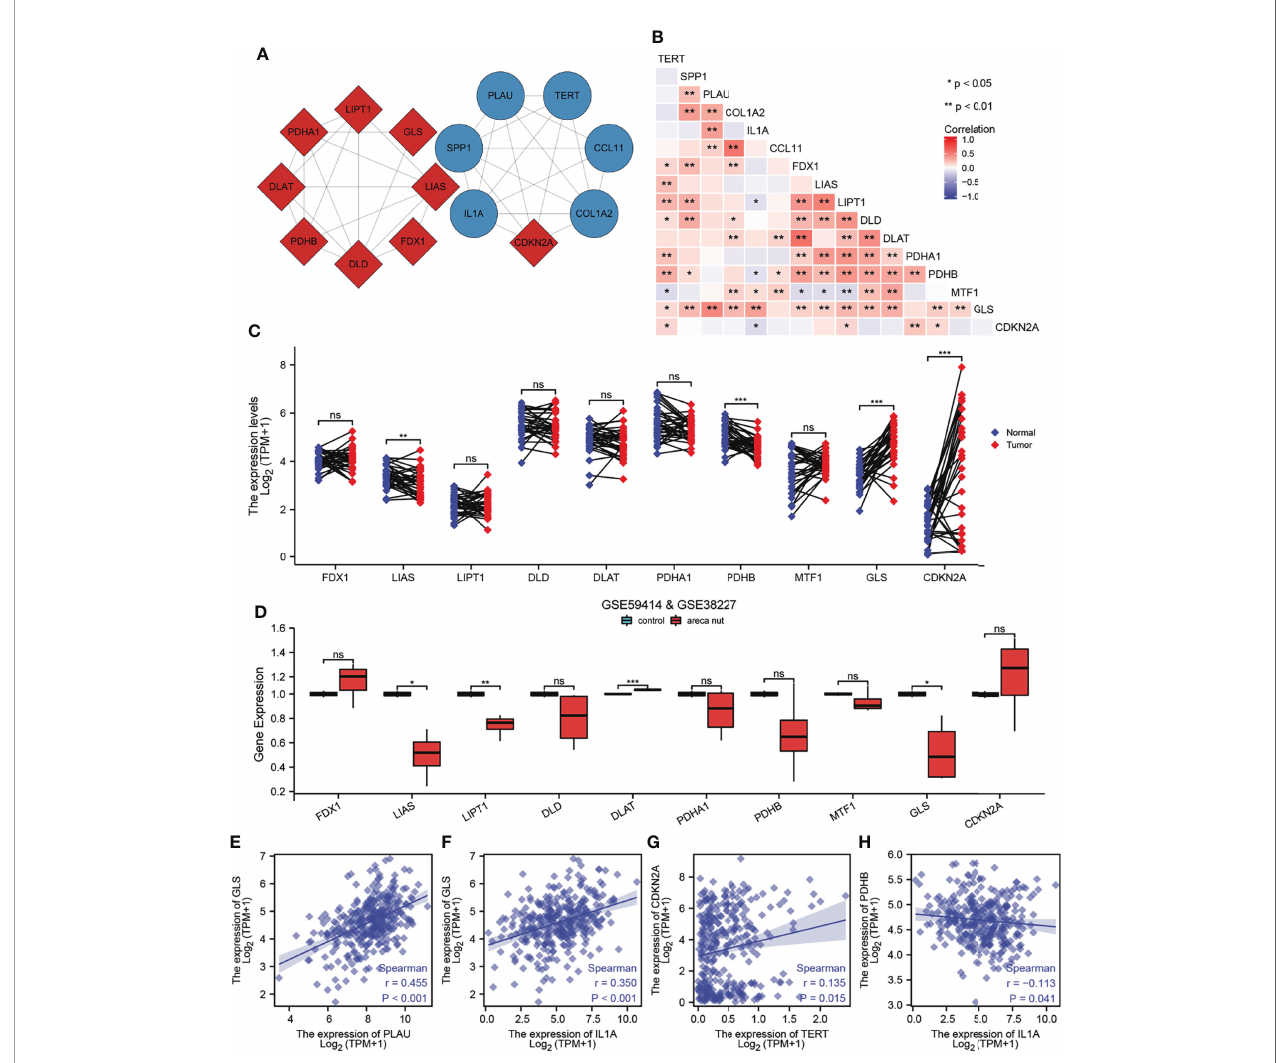
FIGURE 6 | Correlation analysis between AFOC-DEGs and cuproptosis-related genes. (A) PPI network shows bonding between AFOC-DEGs and cuproptosis- related genes. (B) Heatmap shows the correlation between AFOC-DEGs and cuproptosis-related genes; Spearman ’ s correlation analyses were used to analyze the correlations (n = 328, *p < 0.05; **p < 0.01). (C) Differential expression of copper cuproptosis-related genes in OSCC and para-cancer tissues; a paired rank-sum test was used to analyze the data (n = 328, **p < 0.01; ***p < 0.001; ns, not signi fi cant). (D) The difference of cuproptosis-related genes ’ expression in normal oral cells and oral cells treated with 5 m g/ml of areca nut water extract, Box – Cox transformation, and Welch ’ s t-test were used to analyze the data (n = 7, *p < 0.05; **p < 0.01; ***p < 0.001; ns, not signi fi cant). (E) Spearman ’ s correlation analysis between PLAU and GLS (n = 328, r = 0.455, p < 0.001). (F) Spearman ’ s correlation analysis between IL1A and GLS (n = 328, r = 0.350, p < 0.001). (G) Spearman ’ s correlation analysis between TERT and CDKN2A (n = 328, r = 0.135, p = 0.015). (H) Spearman ’ s correlation analysis between IL1A and PDHB (n = 328, r = − 0113, p = 0.041). PPI, protein – protein interaction; OSCC, oral squamous cell